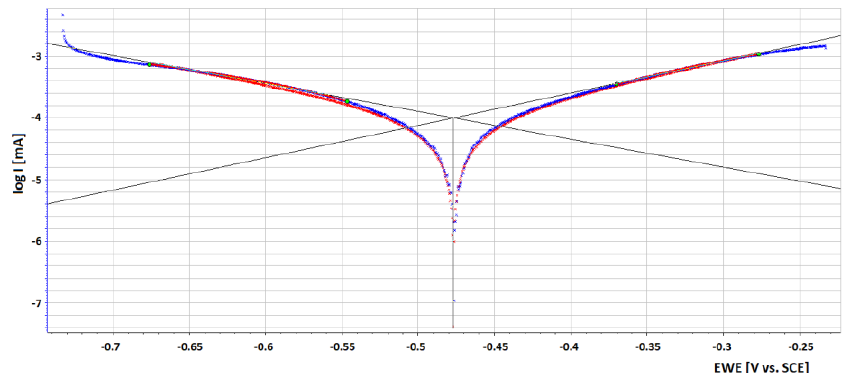
Figure 13. Polarization diagram with logarithmic scale of current density—Tafel extrapolation.